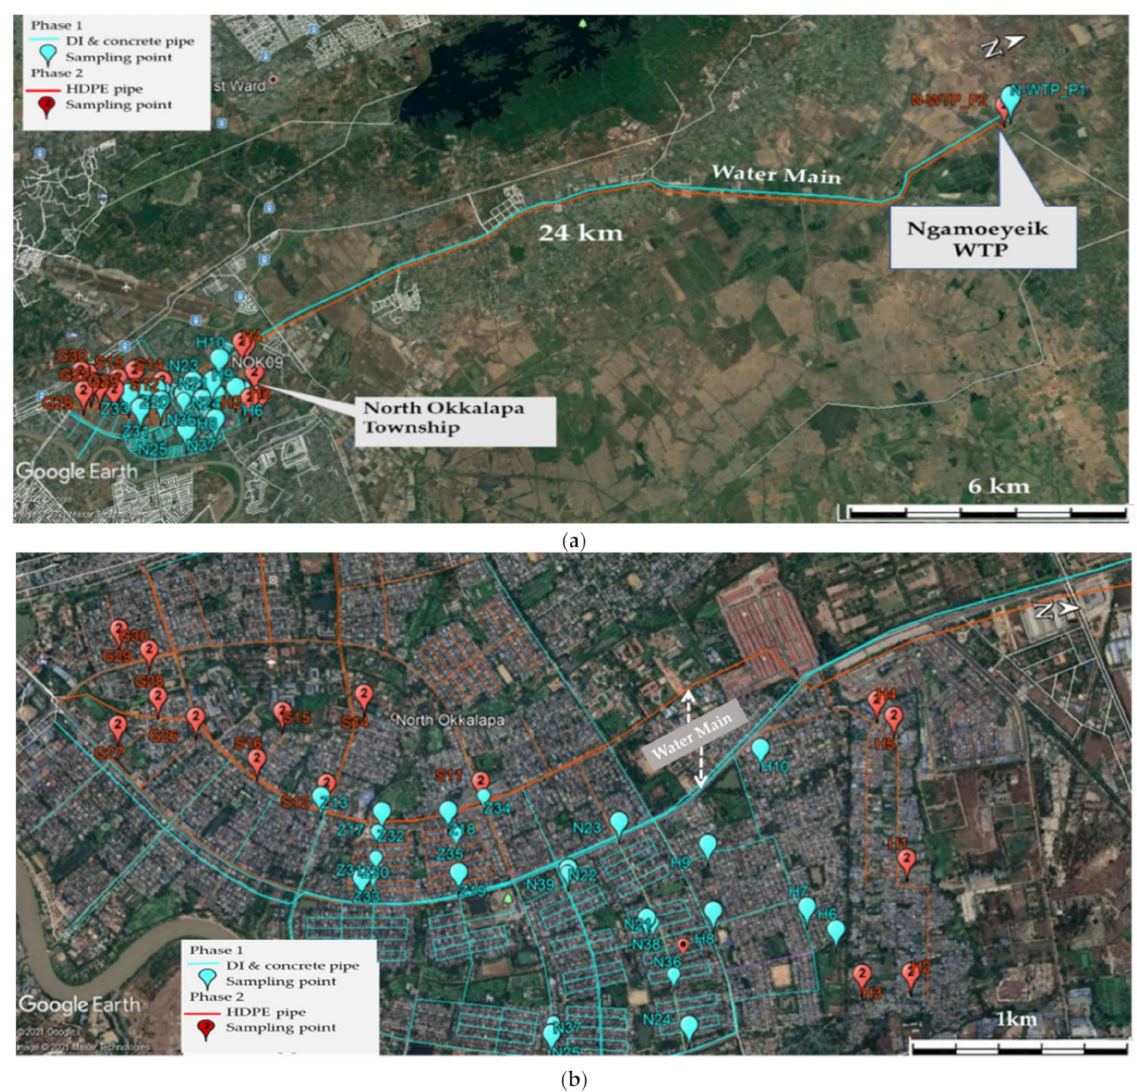
Figure 2. Survey area: ( a ) N-WTP to N-OKP, ( b ) N-OKP